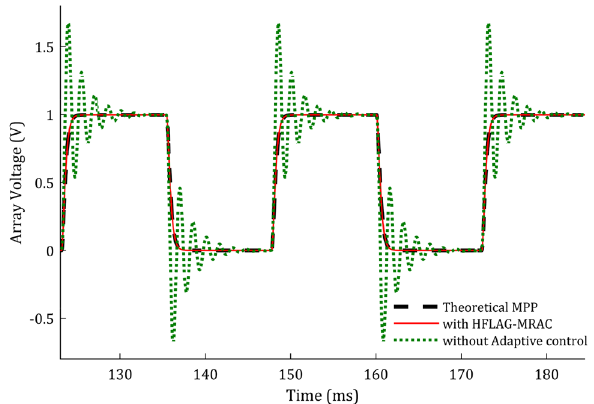
Figure 13. Performance of the theoretical MPP voltage, un-adapted array voltage and the proposed HFLAG- MRAC at late adaptation